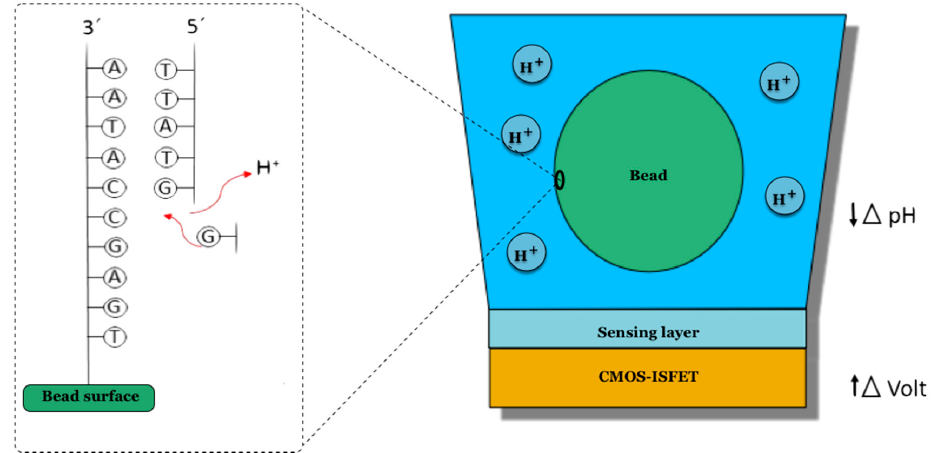
Figure 10. In the Ion Torrent platform, the chip is the sequencer. Each well of the chip acts as a pH meter that is able to detect changes in the concentration of H+ produced in DNA polymerization.